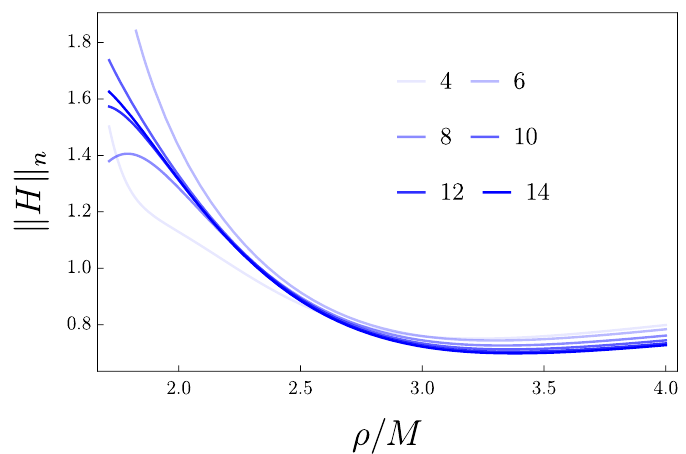
Figure 11 . Convergence of the norm of the H i functions, k H k n . We show the pro(cid:12)le of k H k n in the axis x = 1, (cid:26) (cid:21) (cid:26) + for the values of n indicated, for spin (cid:31) = 0 : 7, and for couplings (cid:11) 1 = 0 : 5, (cid:11) 2 = 0 : 7, (cid:18) m = (cid:25)= 4, (cid:21) ev = (cid:21) odd = 1. The accuracy of the expansion up to n = 14 at (cid:26) = (cid:26) + is around 1%, but the convergence is much better as we move far from the